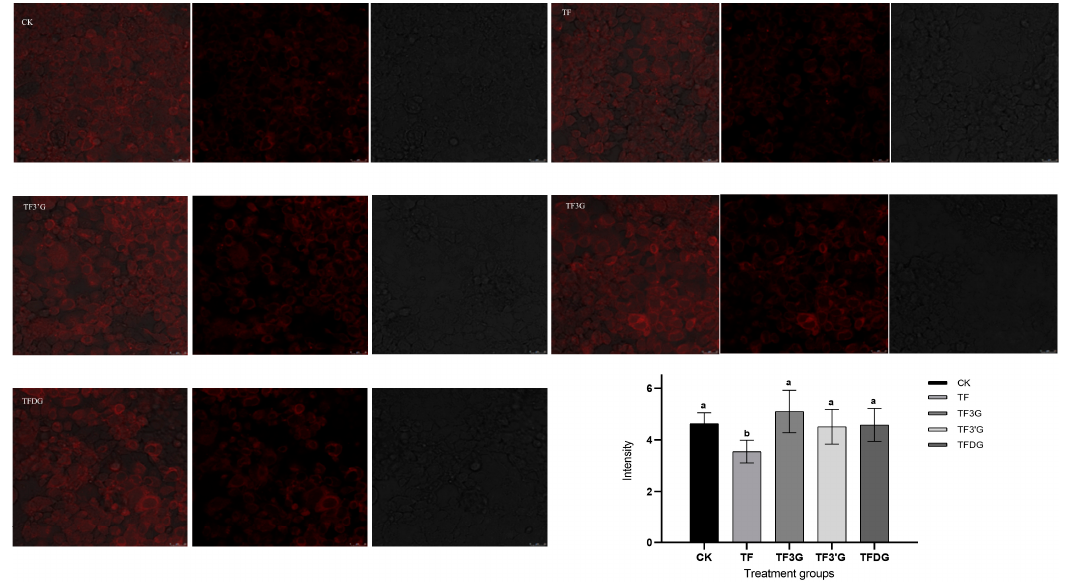
Figure 5. F − fl uorescence localization and mean fl uorescence intensity of Caco-2 cells in di ff erent Figure 5. F − fluorescence localization and mean fluorescence intensity of Caco-2 cells in different treatment groups. Each group photos from left to right were the overlap fi eld, fl uorescence fi eld, treatment groups. Each group photos from left to right were the overlap field, fluorescence field, and and light fi eld, respectively. Di ff erent lowercase le tt ers in the same group indicate signi fi cant dif- light field, respectively. Different lowercase letters in the same group indicate significant differences ferences at p < 0.05. at p <